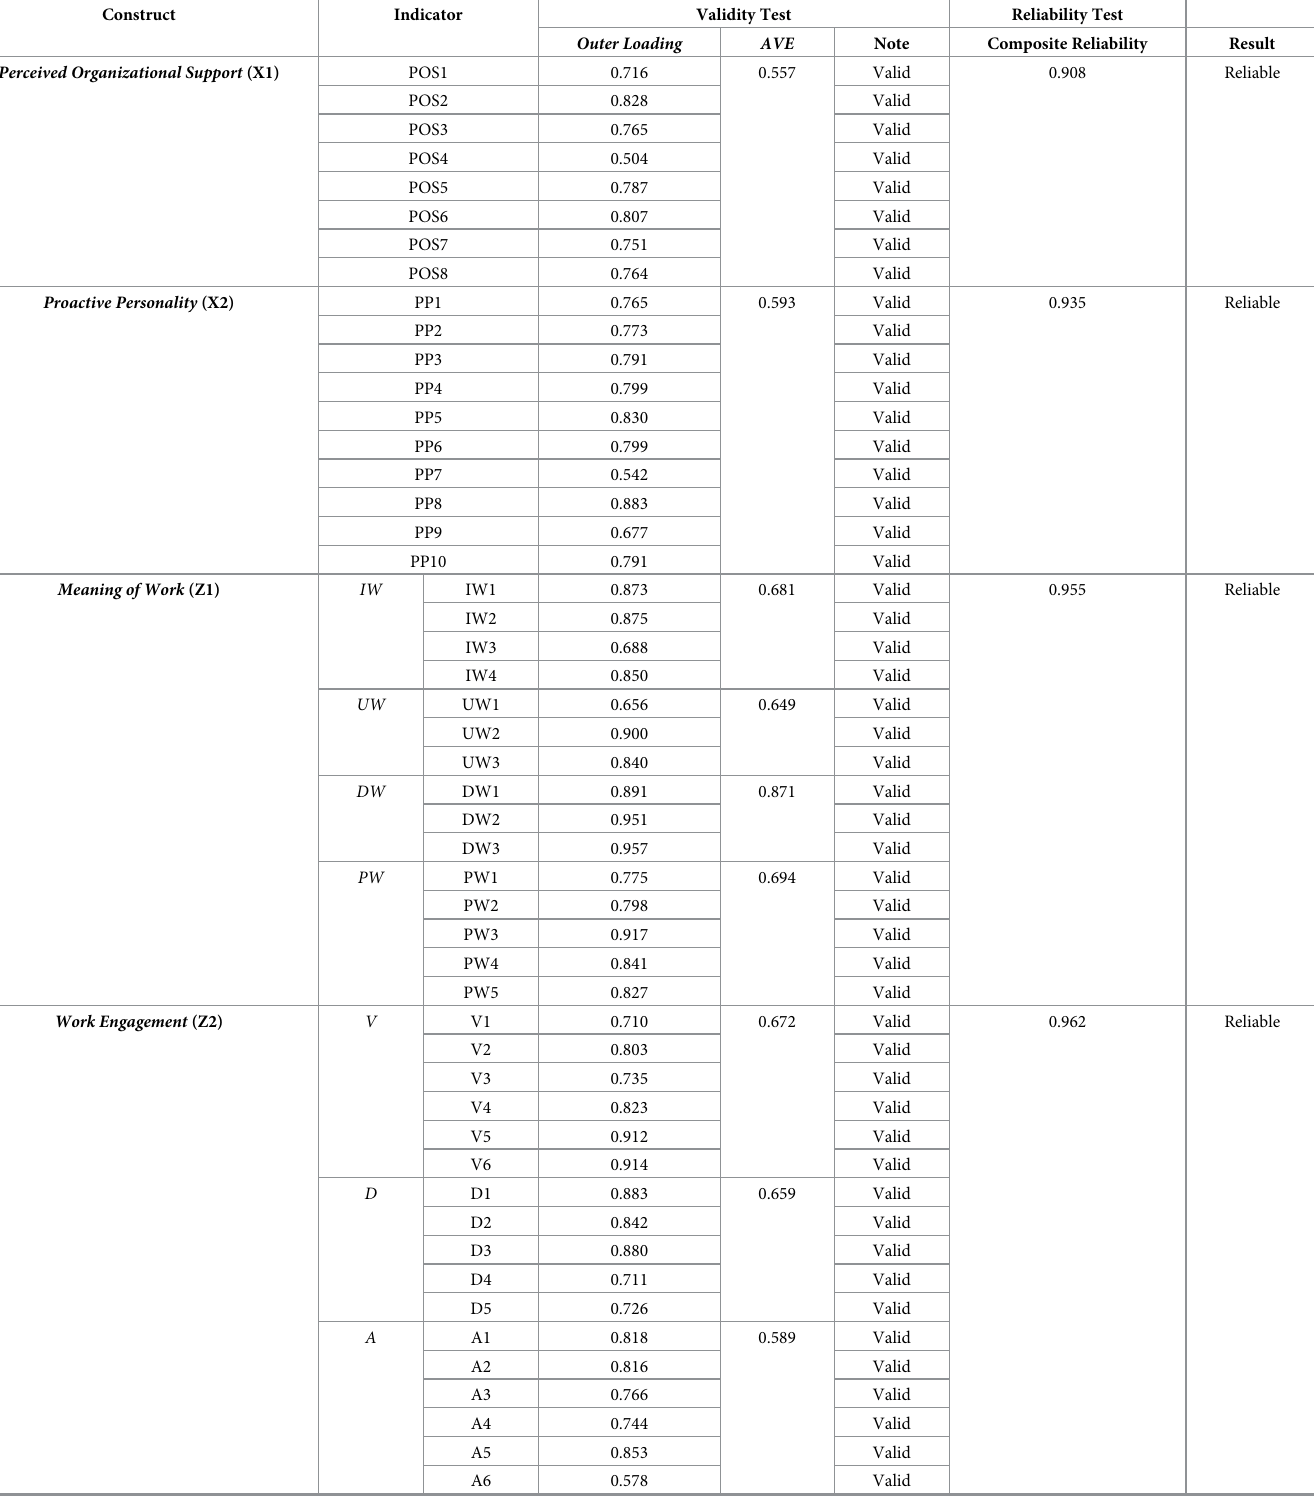
Table 2. Outer model